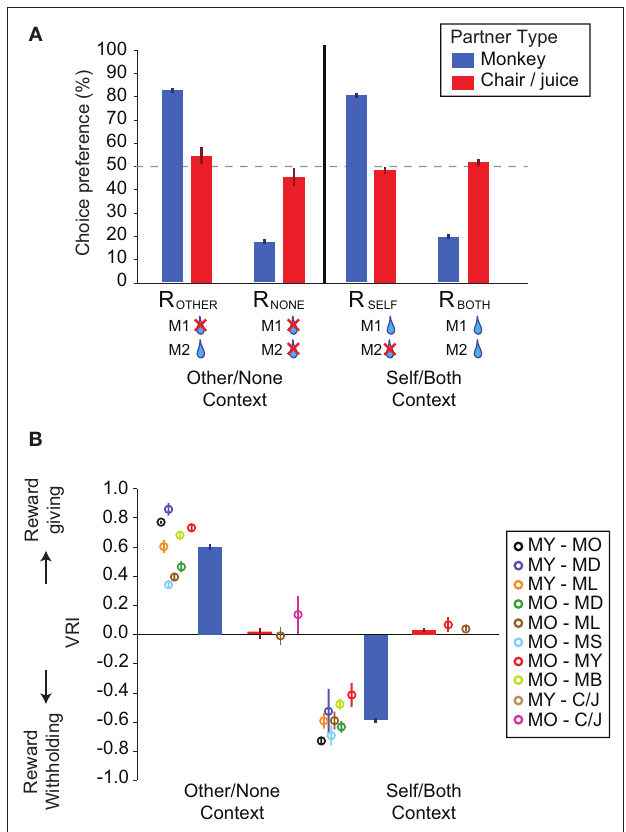
Figure 3 | Context-dependent vicarious reinforcement drives the expression of other-regarding preferences in rhesus macaques. (A) Choice preferences (median of all sessions ± SEM) in the Other/None and Self/Both contexts across M1–M2 pairs (8 pairs, 64 session) and M1–chair/juice controls (2 pairs, 13 sessions). (B) Choice preferences expressed as VR indices (median of all sessions ± SEM) in the Other/None and Self/Both contexts across M1–M2 pairs (see box for individual pair medians and standard deviations (SDs) for their ranges) and M1–chair/juice controls. Bars are color-coded by the partner type in both panels (see box in A